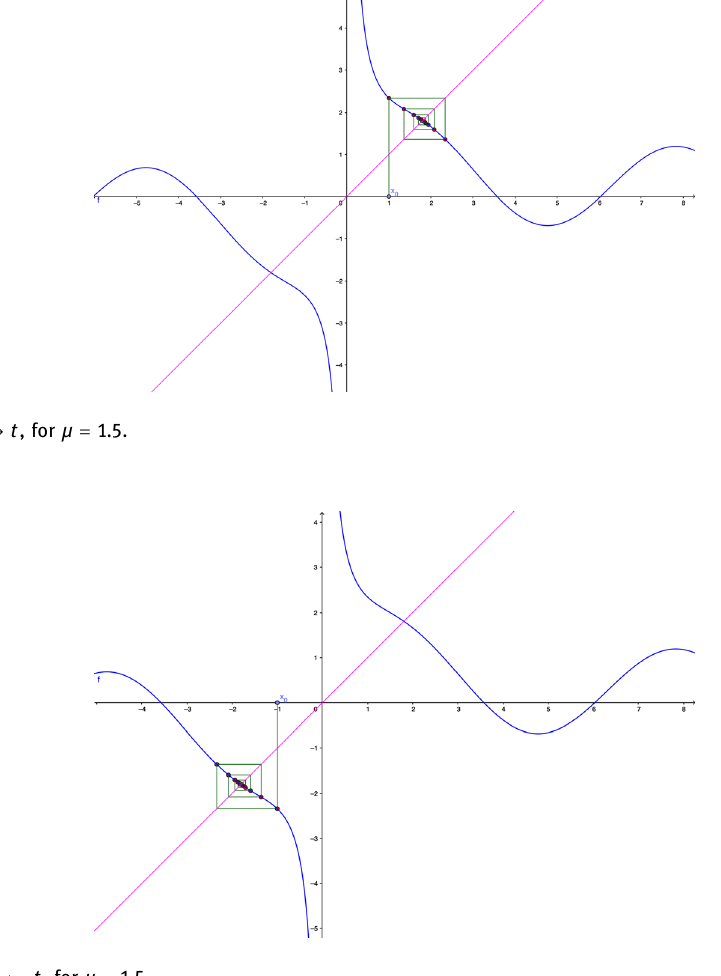
Figure 11: f t −1 − μn ( ) → , for μ 1.5 =